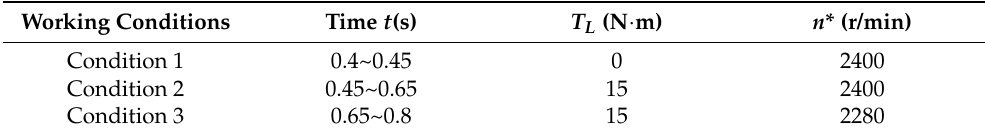
Table 7. The motor working conditions.